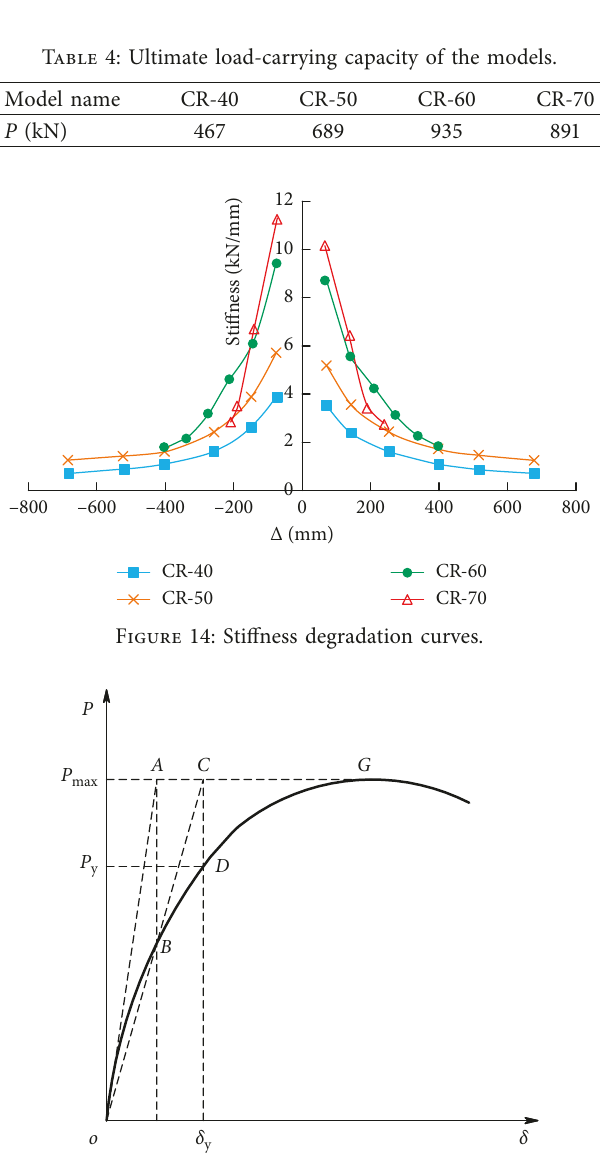
Figure 15: Method based on equivalent elastic-plastic yield.